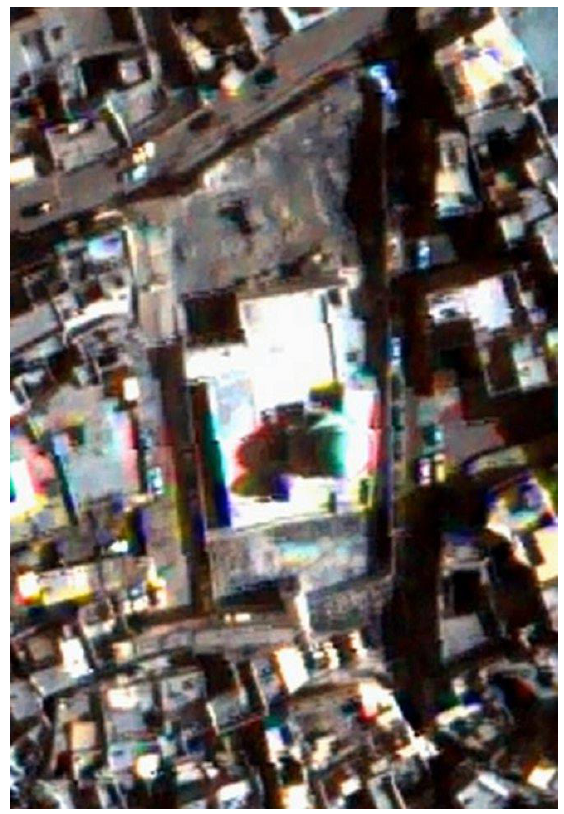
Figure 7. Complex of the mosque dedicated in 1300 to the Prophet Nabi Jirijs in Nineveh before the events